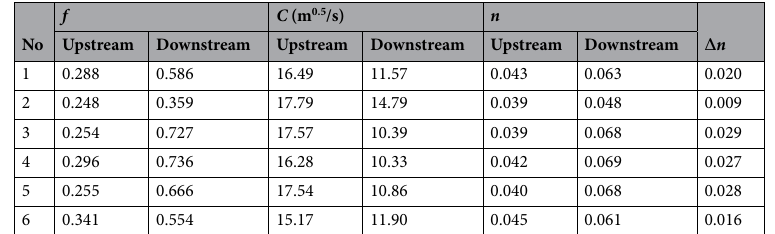
Table 4. Calculation results of flow resistance including f , C , and n for each test. Note: f = friction factor; C = Chezy coefficient; n = Manning roughness coefficient; ∆ n = increased value of the roughness coefficient n from upstream to